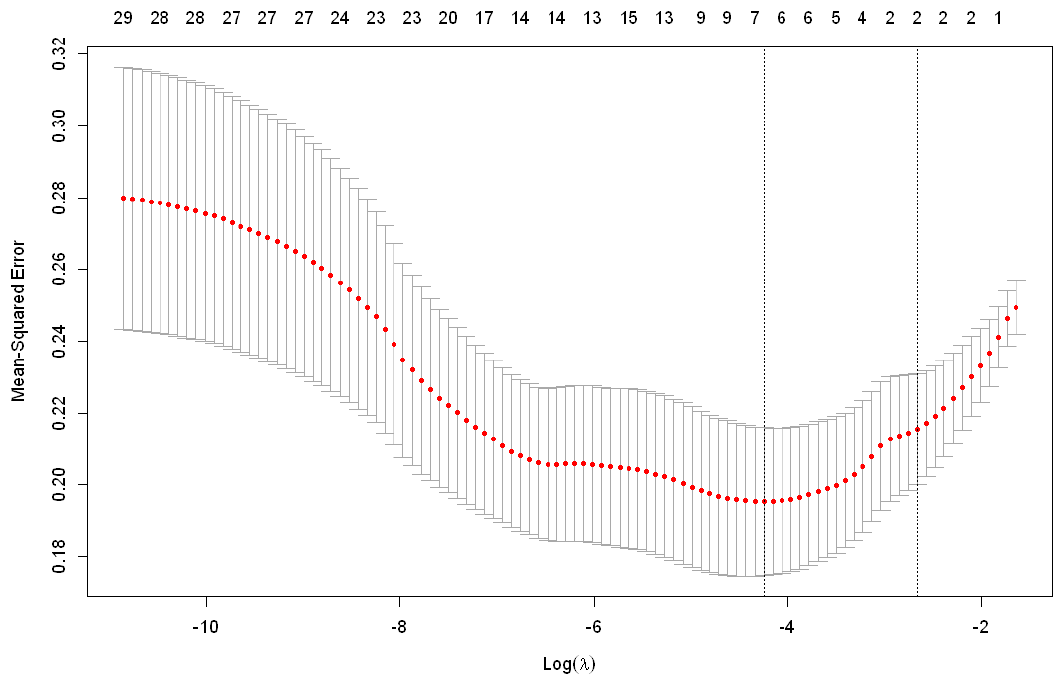
Figure 1. Graphical representation of MSE values obtained by cross ‐ validation used to select the best lambda value.